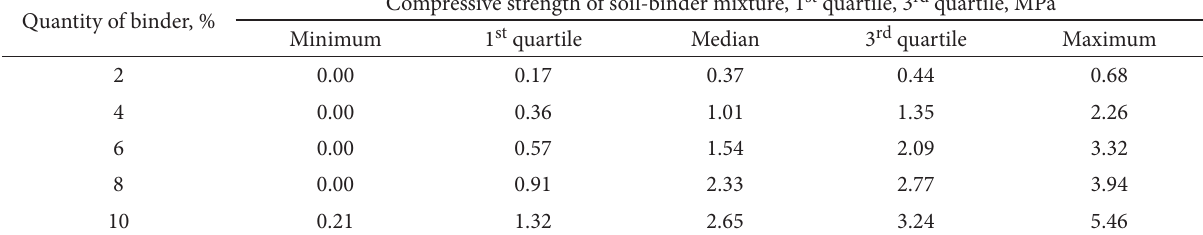
Table 3. Statistical parameters for the compressive strength R c of soil-binder mixtures after hardening for 28 days, depending on quantity of hydraulic binder added Quantity of binder,